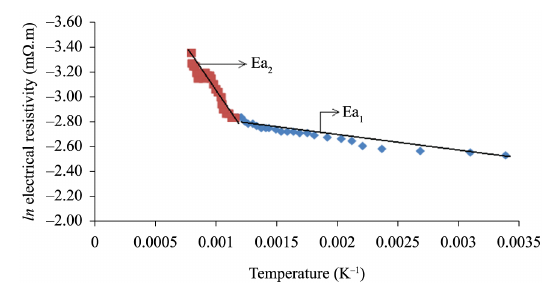
Figure 9. The Arrhenius plot of ln electrical resistivity as a function of T –1 in the temperature. showing Ea Ea = 10.9 kJ.mol –1 . 2